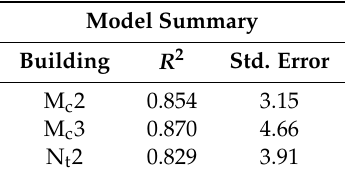
Table 3. Summary statistics for the PALM-GIS model for NO 2